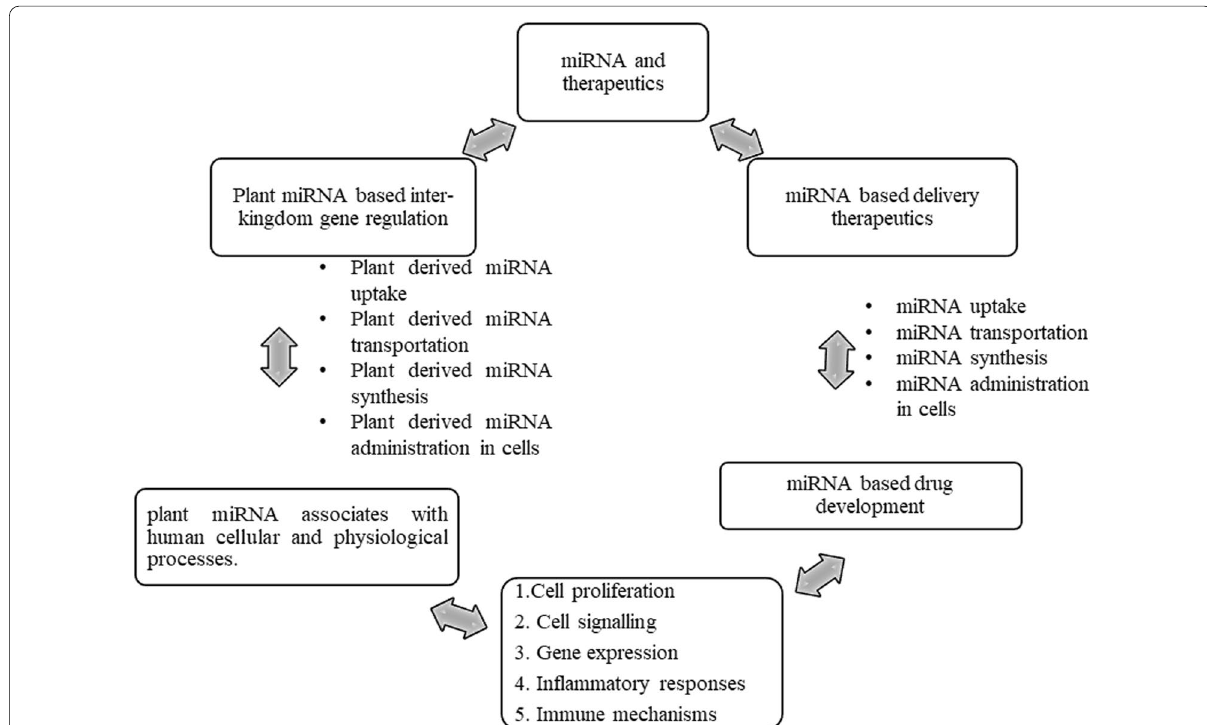
Fig. 4 In miRNA-based delivery therapy, miRNA uptake, miRNA transportation, miRNA synthesis, and miRNA administration are all included. miRNA-based therapeutics are being developed to treat cell proliferation, cell singling, gene expression, inflammatory responses, and immunological processes. Furthermore, plant miRNA absorption, transportation, synthesis, and administration are all predicted for inter-kingdom